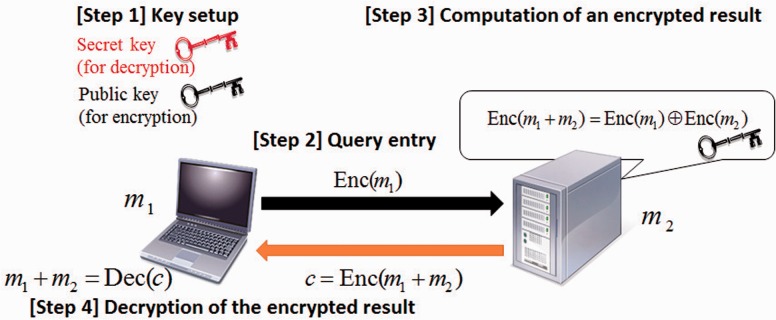
Computation of m1+m2 on the server in encrypted form by additively homomorphic encryption